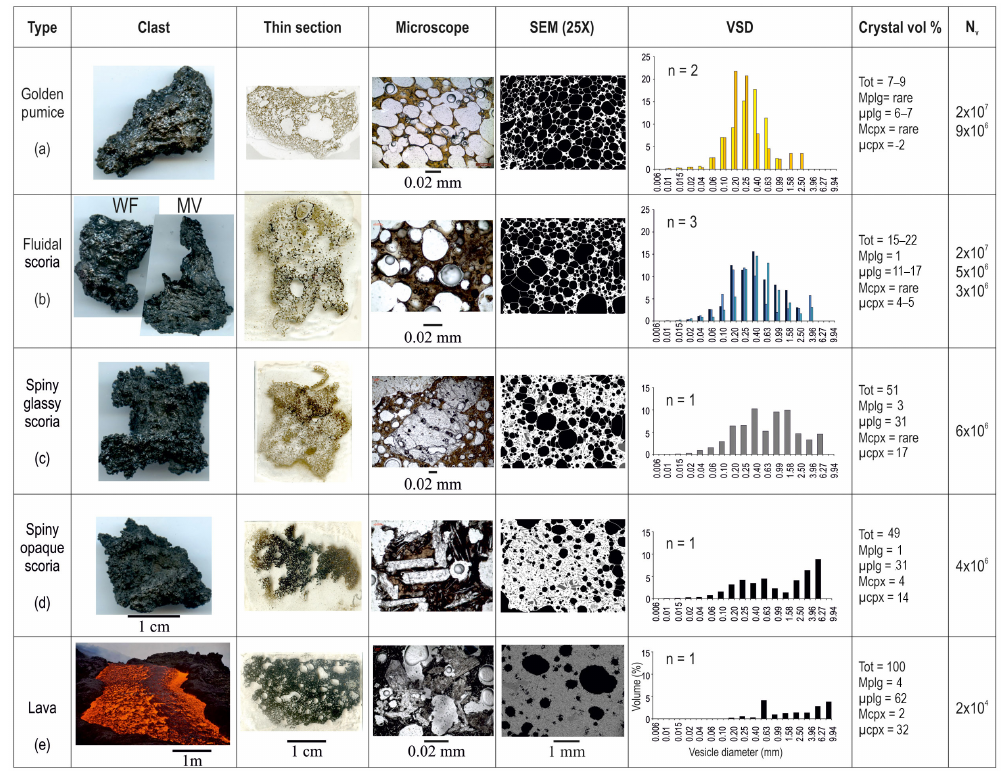
Figure 4. Textural features of June 2014 pyroclasts and lava. Clast shows a photo of the different types of juvenile pyroclasts and lava channel. The photo of the lava channel is from Laurent Perrier. WF: western fracture (smooth fluidal scoria); MV: main vent (fluidal scoria, less smooth than the ones at the WF). Thin section is the thin section imaged with a desktop scanner. Microscope is the picture taken with an optical microscope using natural light. SEM (25X) is the image captured using scanning electron microscopy (SEM) in BSE mode at 25x magnification: black is vesicles, white is glass, grey is crystals. VSD is the vesicle size distribution histograms, where the diameter, in millimetres, is plotted versus the volume percentage. n : number of measured clasts; crystalvol.%. Tot: total percentage of crystals corrected for the vesicularity; Mplg: percentage of mesocrysts of plagioclase; µ plg: percentage of microcrysts of plagioclase; Mcpx: percentage of mesocrysts of pyroxene; µ cpx: percentage of microcrysts of pyroxene; N v : number density corrected for the